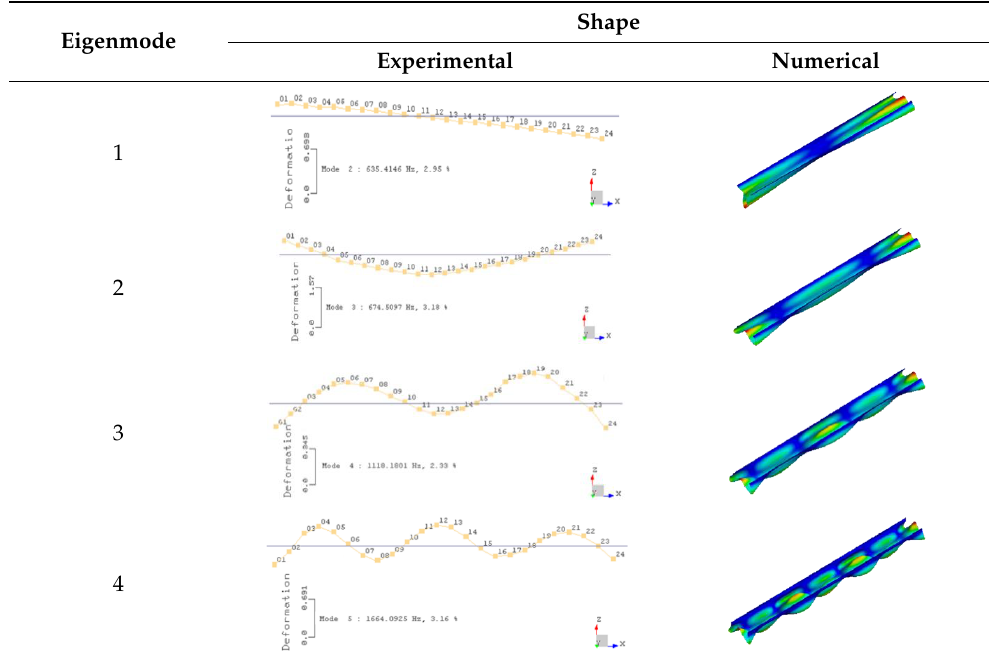
Table 4. Comparison between experimental and numerical eigenmode shapes in half-cane samples.